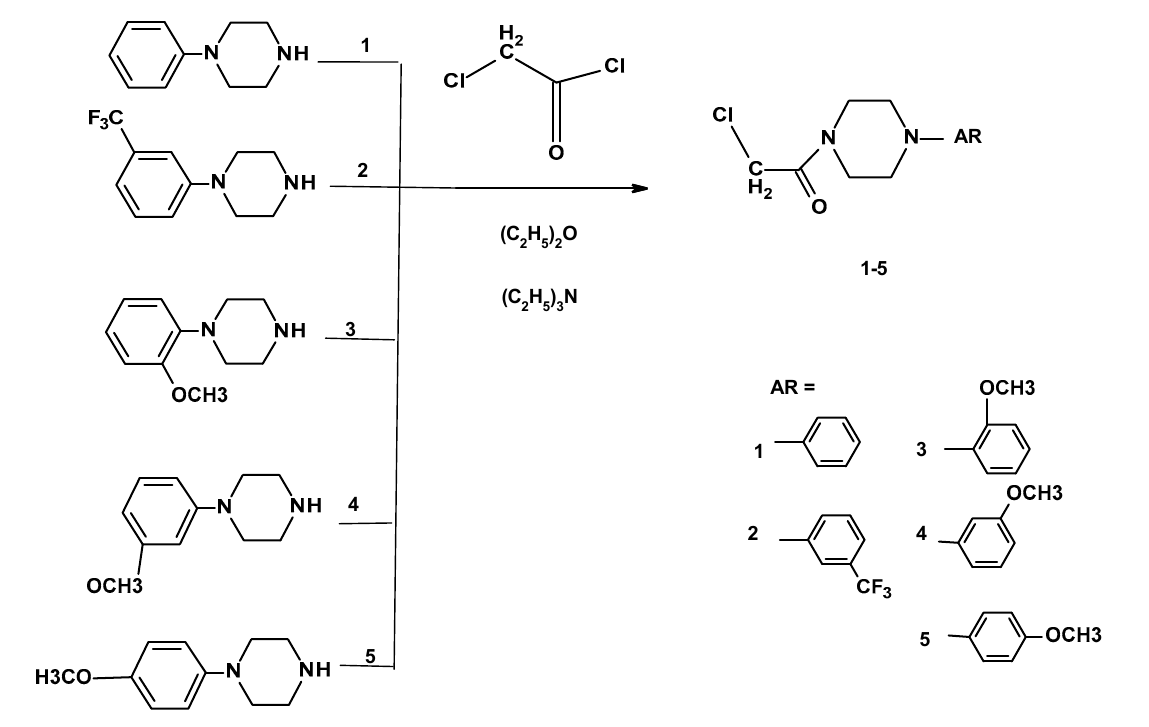
Scheme 3. Method of synthesis of 1-chloroacetyl-4-aryl-piperazine derivatives 1 – 5